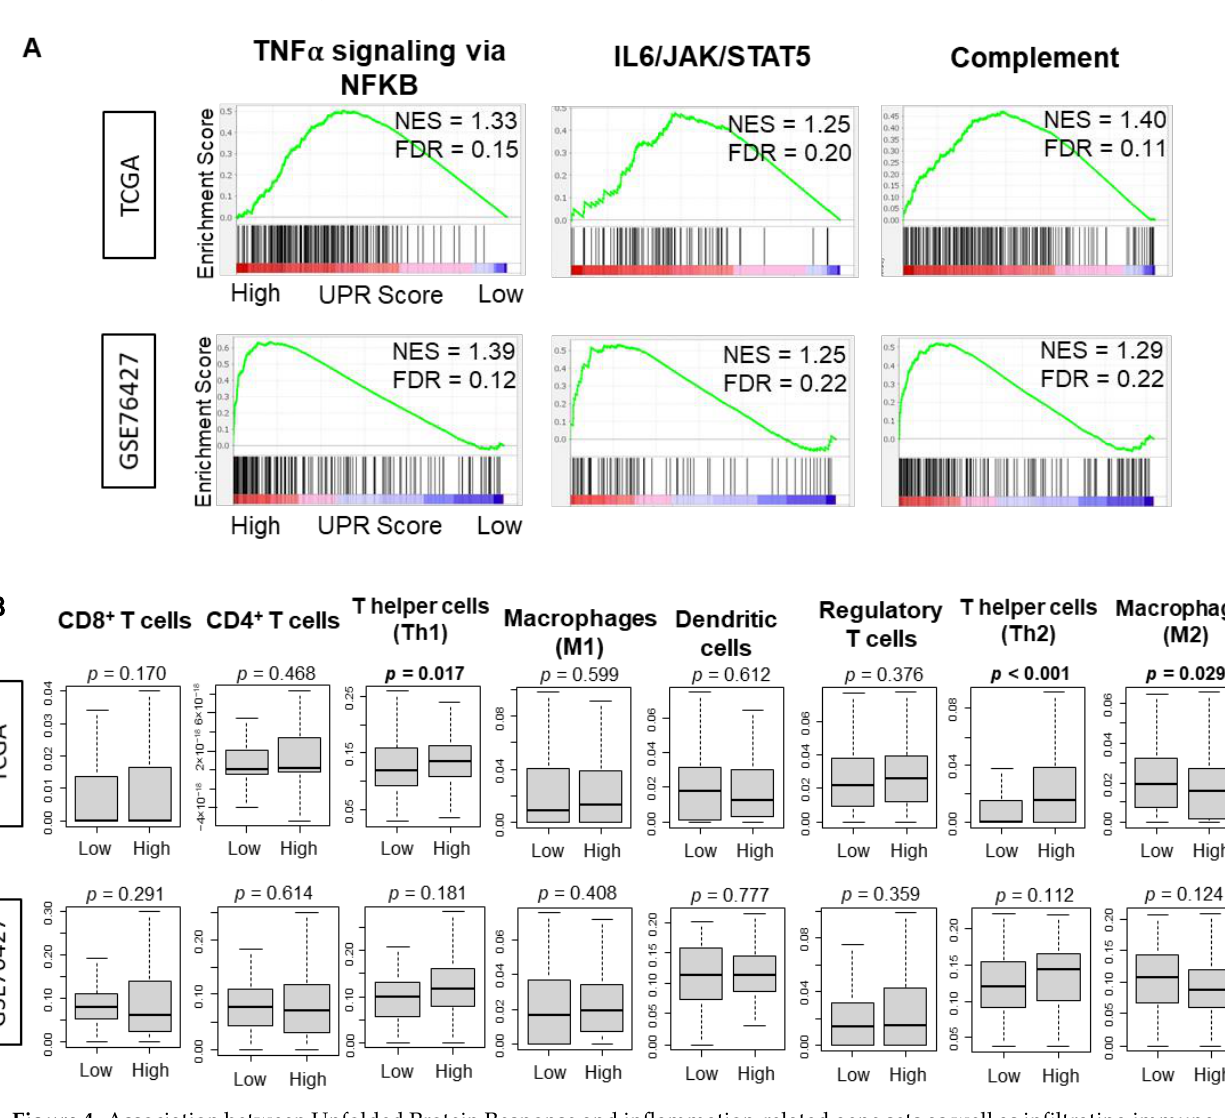
Figure 4. Association between Unfolded Protein Response and inflammation-related gene sets as well as infiltrating immune cells in the TCGA and GSE76427 cohorts. ( A ) Enrichment plots with the normalized enrichment score (NES) and false discovery rate (FDR) for the TNF α signaling via NFKB, IL6/JAK/STAT5, and complement gene sets of the Hallmark gene sets. ( B ) Boxplots of the anti-cancer immune cells including CD8 + T cells, CD4 + T cells, T helper type 1 (Th1) cells, M1 macrophages and dendritic cells; and pro-cancer immune cells including regulatory T cells, T helper type (Th2) cells, and M2 macrophages. The p -value was calculated using the Mann-Whitney U test. Bold format: Significant p values.